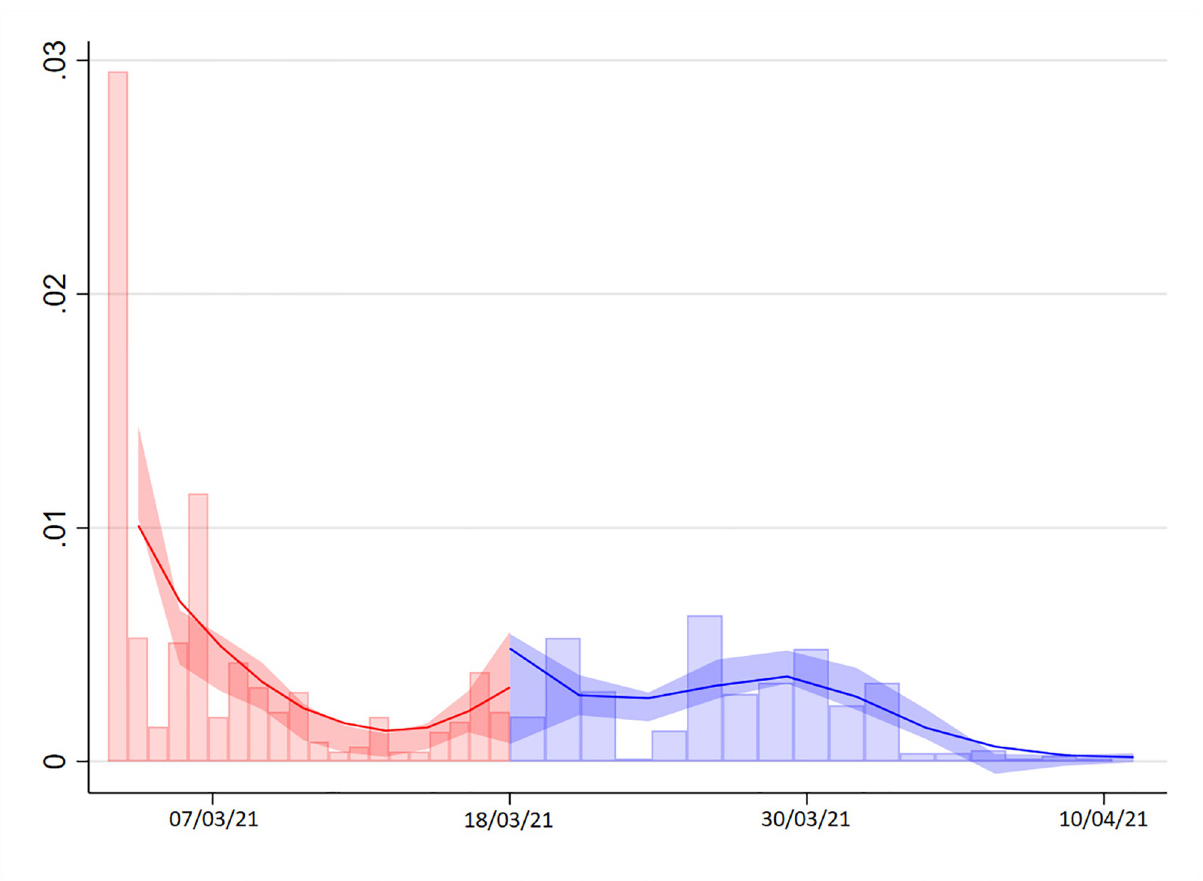
Fig 3. Density of survey responses over time. Notes: Manipulation test using the local polynomial density estimators proposed in [17, 18]. Stata command rddensity. A local quadratic approximation with kernel triangular weights is used to construct the density estimators, while a cubic approximation is used for the bias-corrected density estimator. The density estimation method is unrestricted (two-sample). Robust bias-corrected statistic with jackknife standard errors and uniform confidence interval at 95% level (2000 of simulations).